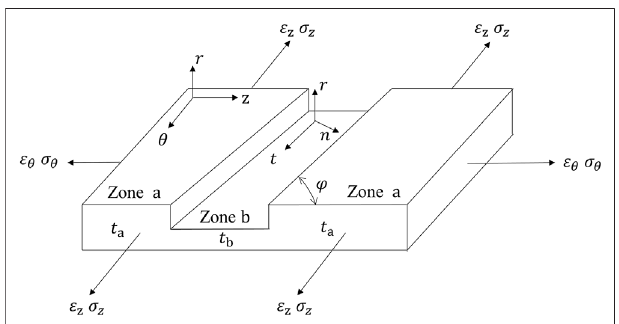
FIGURE 4 | Schematic diagram of the M-K